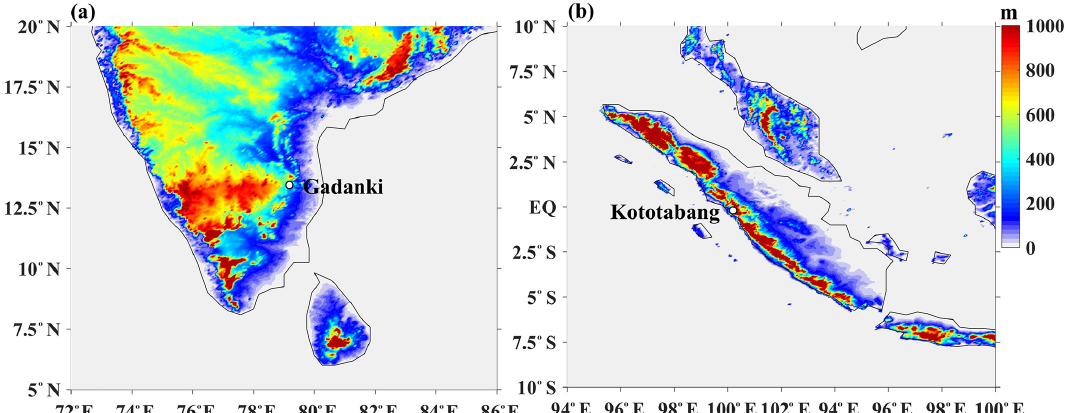
Figure 1. Topographical maps of the (a) IMSTR and (b) Kototabang EAR sites in mean sea level (MSL), generated by using the Shuttle Radar Topography Mission (SRTM) data (Farr et al., 2007). Dots on the map indicate the radar